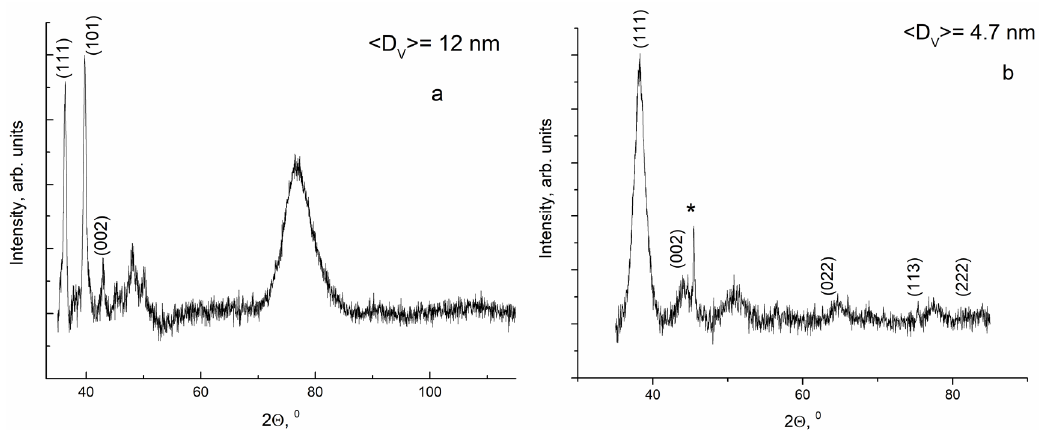
Figure 2. X-ray diffraction patterns of ( a ) silver nanoparticles (AgNPs) and ( b ) gold nanoparticles (AuNPs) measured at room temperature and fitted by the Rietveld method.